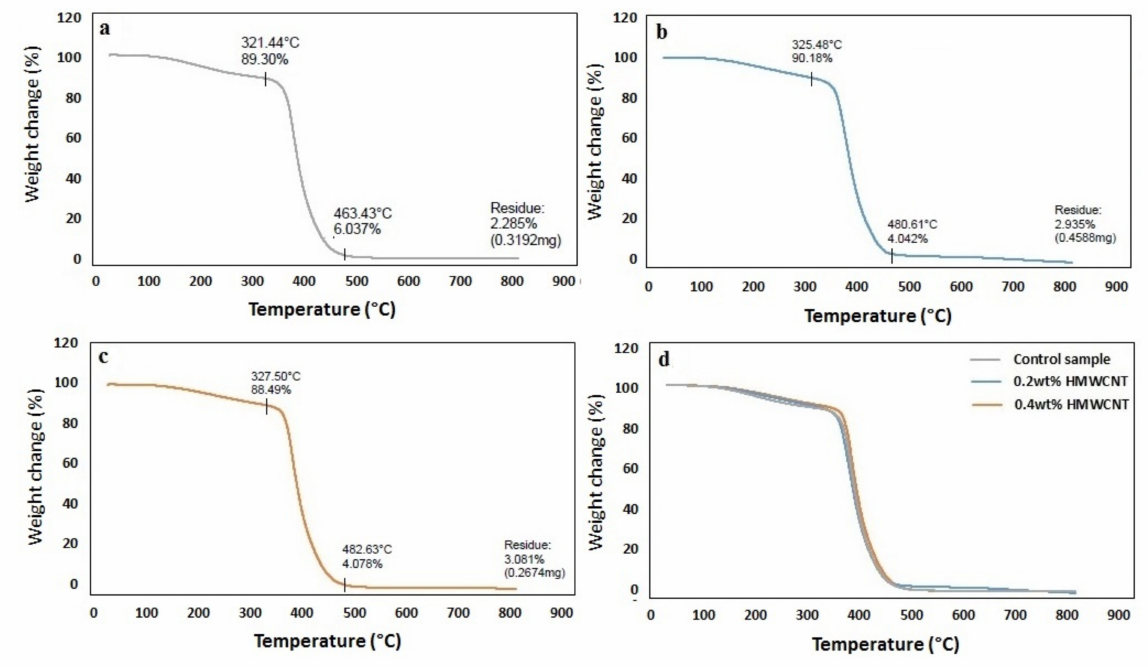
Figure 10. TGA analysis of the ( a ) control sample, the ( b ) 0.2 wt.% HMWCNT, the ( c ) 0.4 wt.% HMWCNT, and a ( d ) comparison of all of the